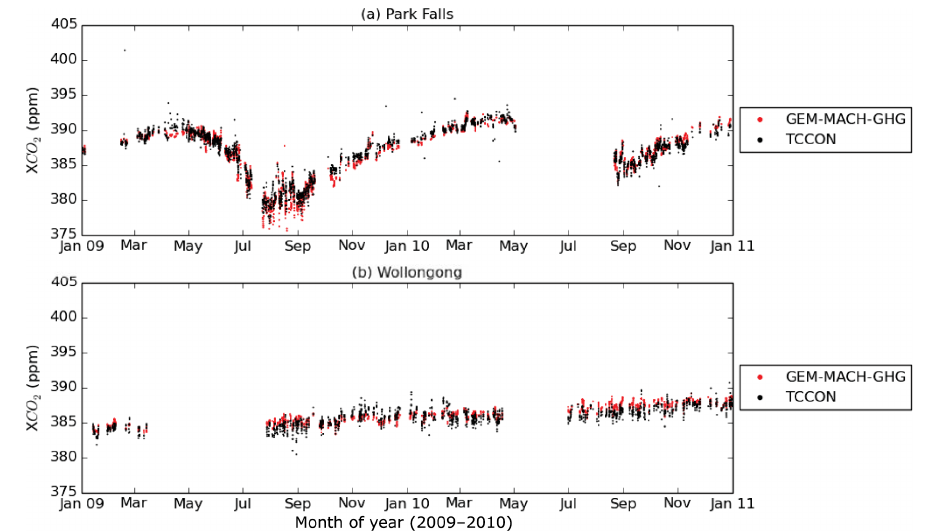
Figure 7. Time series of X CO (ppm) at (a) Park Falls, USA, and (b) Wollongong, Australia, between 1 January 2009 and 1 January 2011. 2 The dots are hourly averaged X CO for TCCON (black) and smoothed GEM-MACH-GHG simulations obtained using CT2013B posterior 2 fluxes